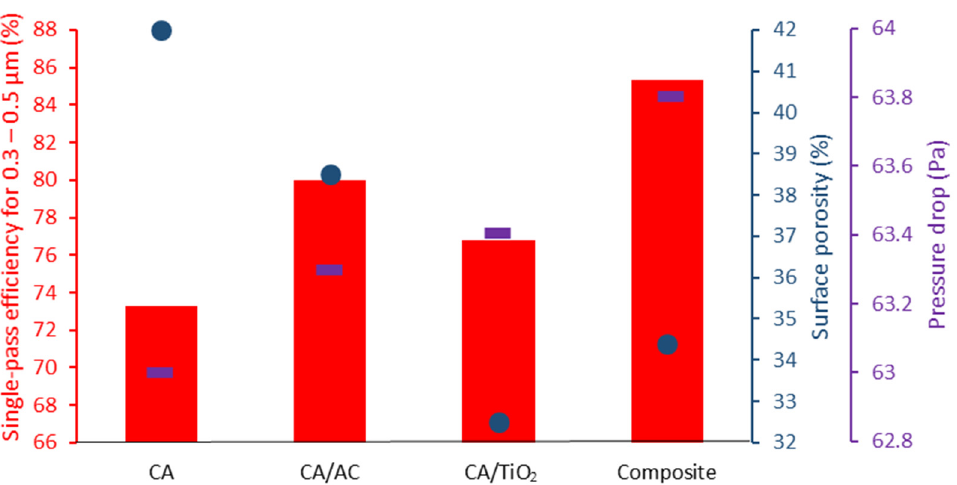
Figure 9. Single-pass filtration efficiency for particle size between 0.3 and 0.5 μ m, surface porosity, and pressure drop.